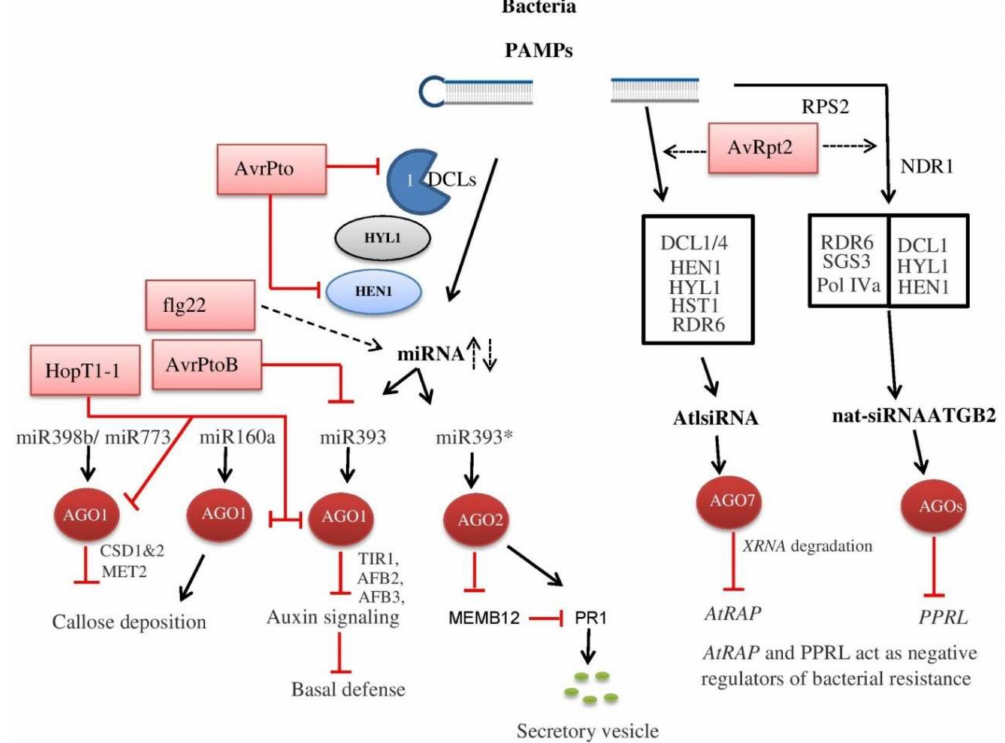
Figure 4. Role of RNAi in plant–bacterial interaction. Upon bacterial infection, plants detect pathogen-associated molecular patterns (PAMP) and control the accumulation of various siRNA or miRNAs through RNAi machinery. These sRNAs either enhance the defense related signals and resistance genes or silence certain genes that negatively regulate plant immunity. In response to the PAMP-triggered immunity (PTI) system, bacteria produce certain effectors that suppress host RNAi mechanism (pink box). Hasty1 (HSTY), Resistance protein 2 (RPS2), Non-race specific disease resistance protein (NDR1), Pentatricopeptide repeats protein-like (PPRL), RNA binding domain abundant in apicomplexans (RAP), MEMB12 (Membrin), Pathogenesis-related protein (PR1), Transport inhibitor response 1 (TIR 1), Auxin signaling F-Box proteins 2 and 3 (AFB2&3), Copper superoxide dismutases 1 and 2 (CSD1&2), Methyltransferase